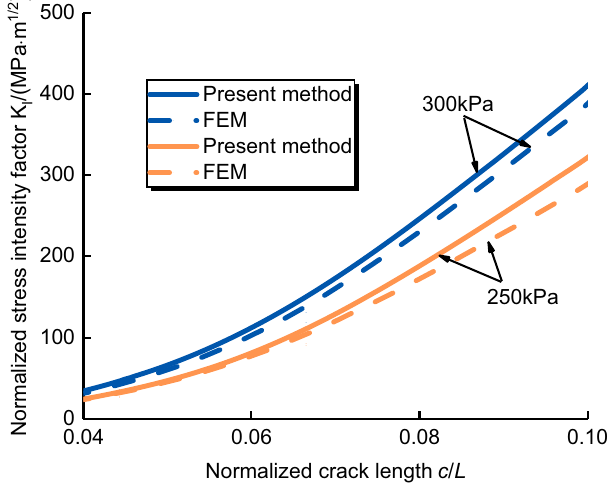
Figure 10. SIFs for crack tip of the elastic–plastic soils under fracture grouting.